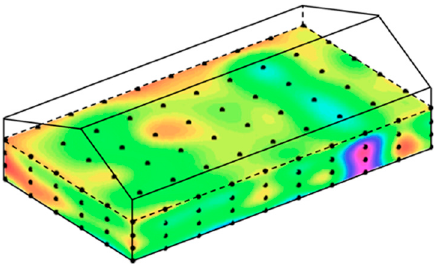
Figure 1. A 3D grain temperature field in a granary. (Note: the cloud is the grain temperature field, and the black dots are the sensor locations).